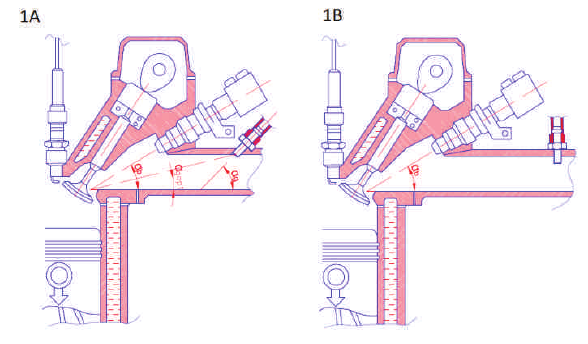
Fig.1. Placement of the gas inlet in the intake manifold: (1A) at an angle in the Al alloy manifold; (1B) perpendicular to the plastic collector